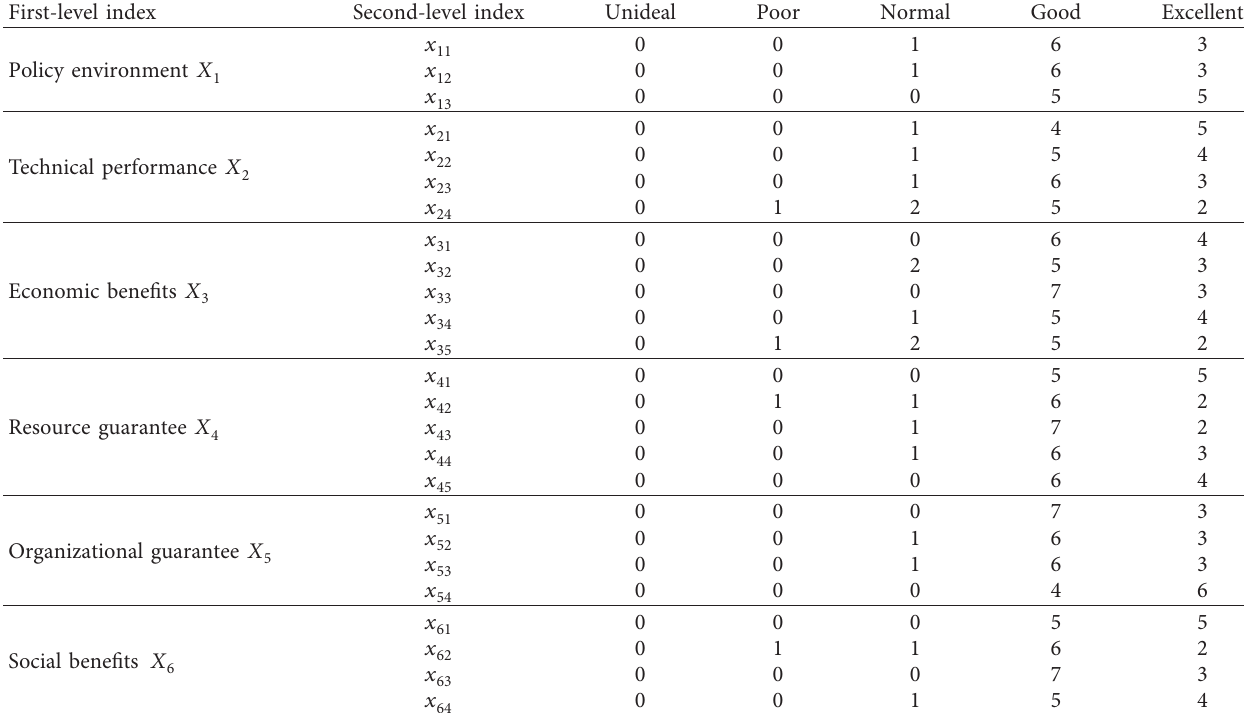
Table 6: Local sci-tech achievement industrialization project pre-evaluation evaluation